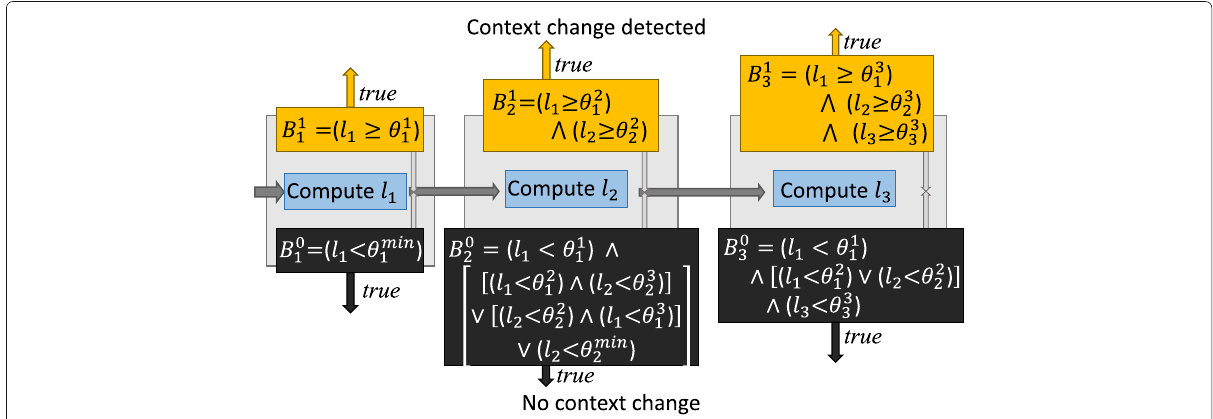
(cid:3) (cid:4) θ 2 θ 3 m , m